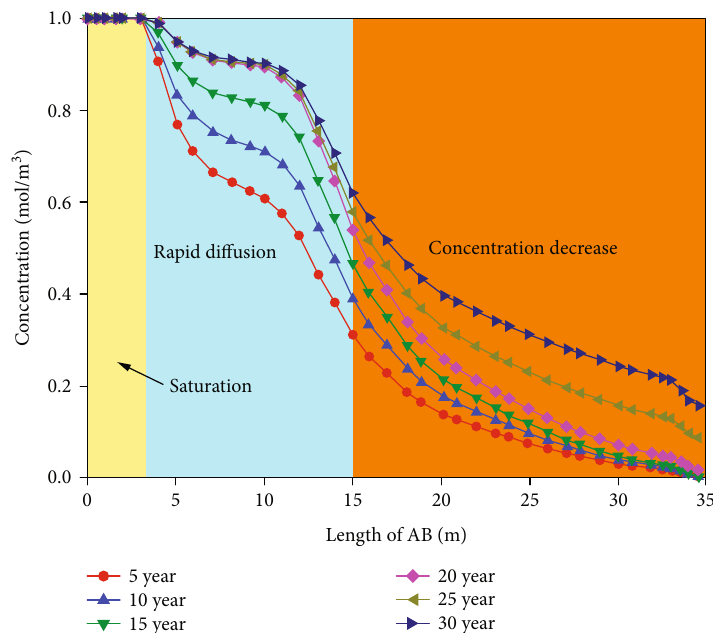
Figure 11: The contaminant concentration along the line of AB in the MFF model.